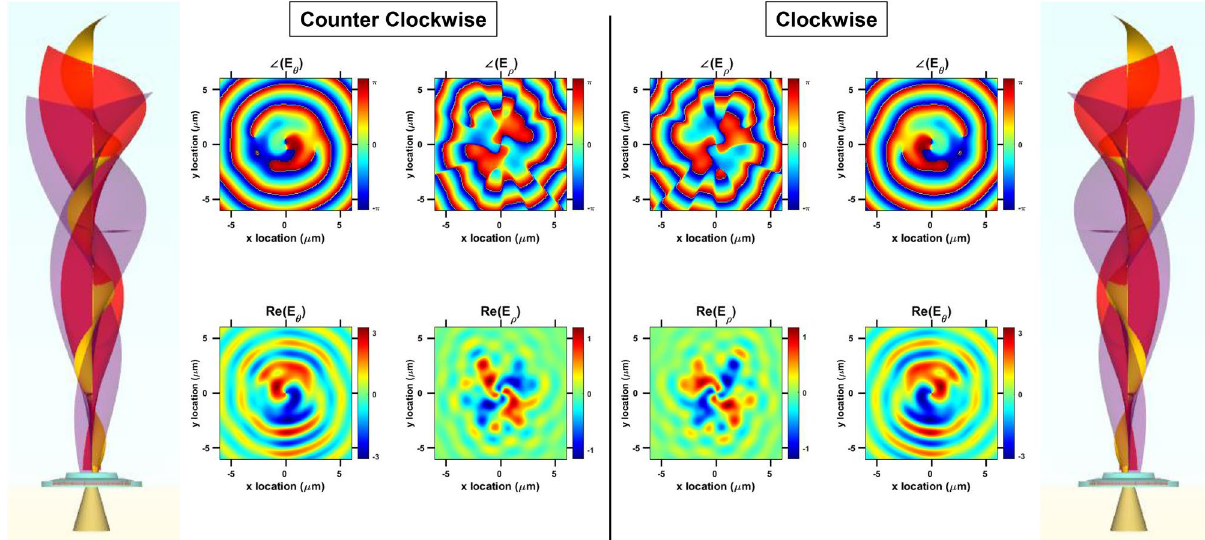
Figure 5. Controllable OAM order and chirality: a sketch representing the expected emission of clockwise (CW) and counter clockwise (CCW) asymmetric micro-gear cavities. Surface plots of the in-plane electric field components and the corresponding phase plots confirm controlling the OAM chirality for different orders. The modes with similar OAM order in CW and CCW cavities correspond to the same WGMs at the same wavelengths. Outermost sub-figures plot ℓ = 1 modes at 1.761 µ m, the innermost sub-figures plot ℓ = 2 modes at 1.709 µ m. The OAM order is defined by the WGM azimuthal order and the number of the